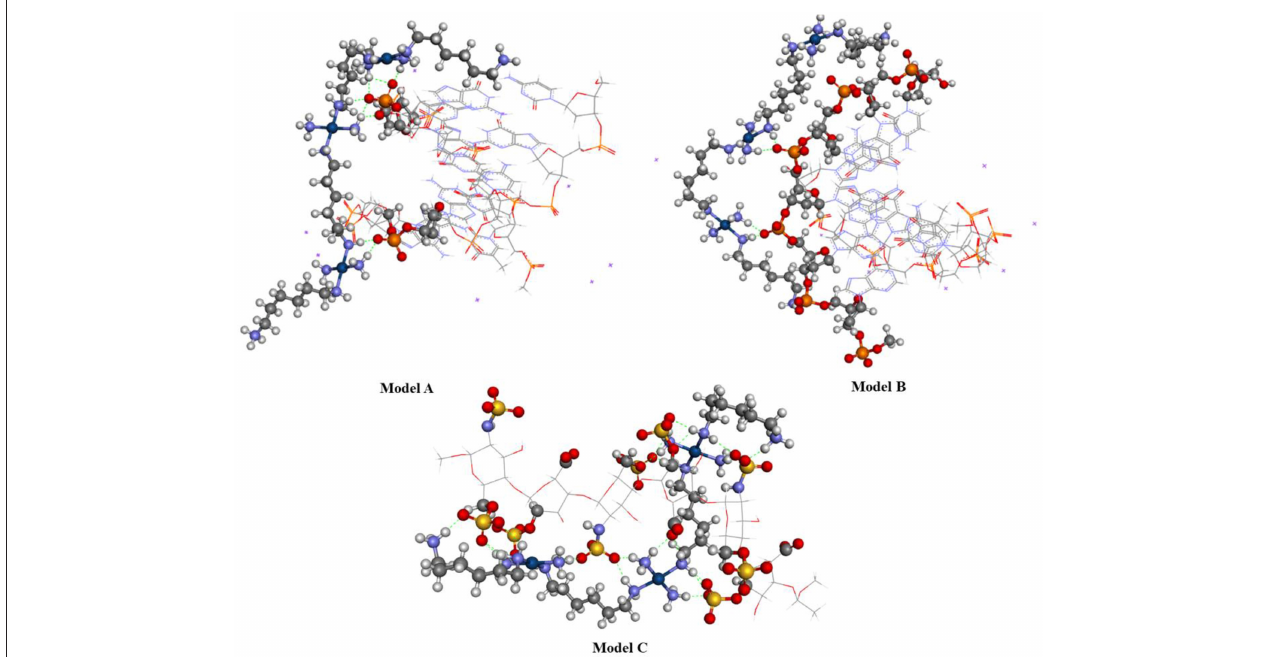
FIGURE 10 | Optimized structure of models (A–C) using the functional BHandH.